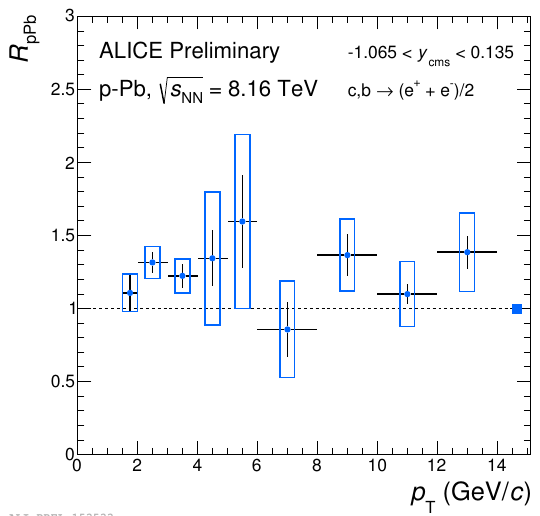
Figure 3. The nuclear modification factors of electrons from heavy-flavour hadron decays in p–Pb √ s NN = 8.16 TeV. collisions at